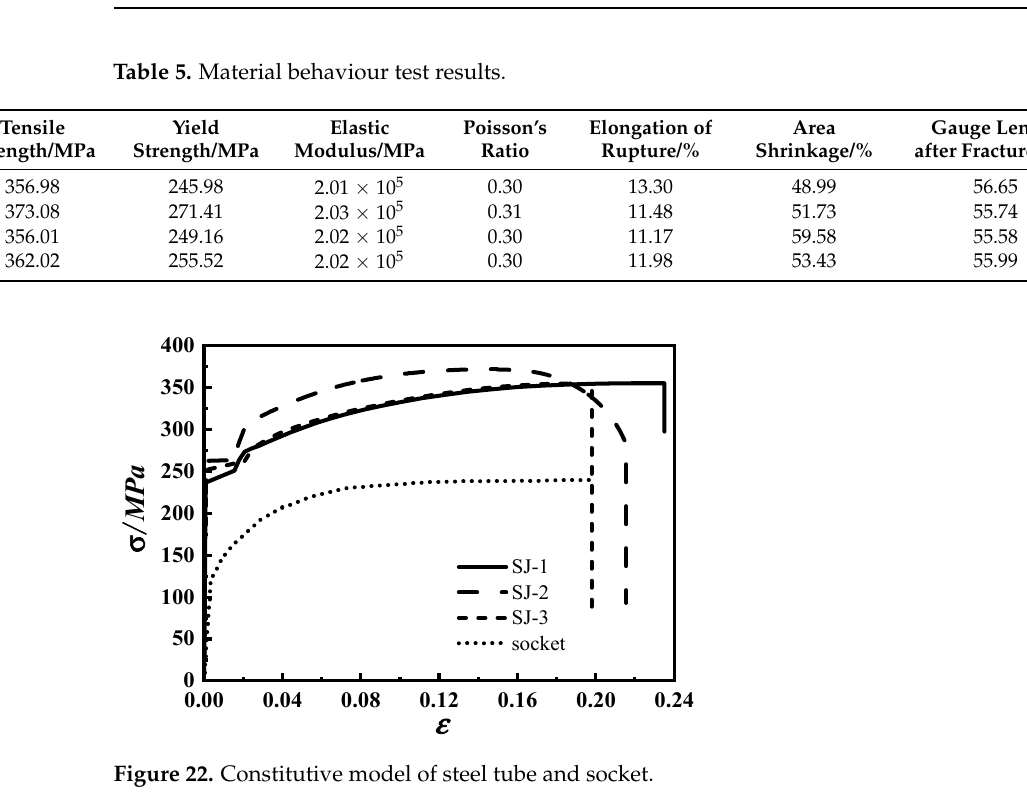
Figure 22. Constitutive model of steel tube and socket.